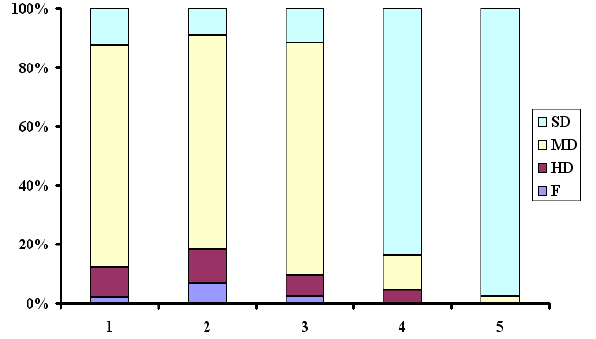
Fig. 17. Beam cross-sectional damage.